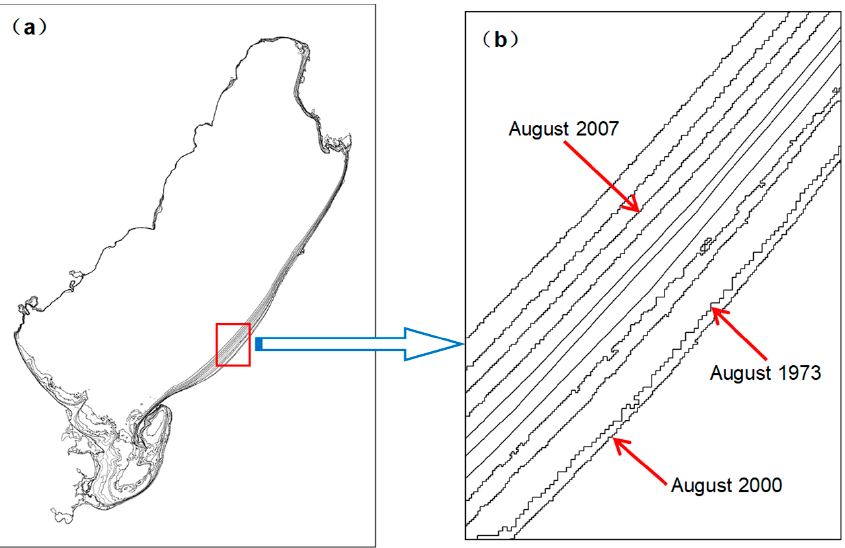
Figure 4. Lake shoreline superimposed on Hulun Lake: ( a ) the entire area of the lake, and ( b ) partial enlargement.